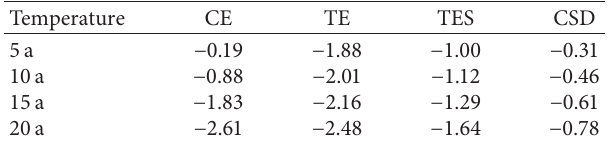
Table 7: Variation of the permafrost table beneath the SE with the sand thickness of 0.7 m in October 15th of 5th, 10th, 15th, and 20th years (unit: